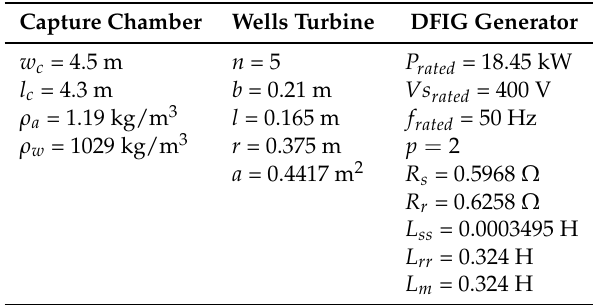
Table 4. Plant parameters from the NEREIDA wave power plant at Mutriku.